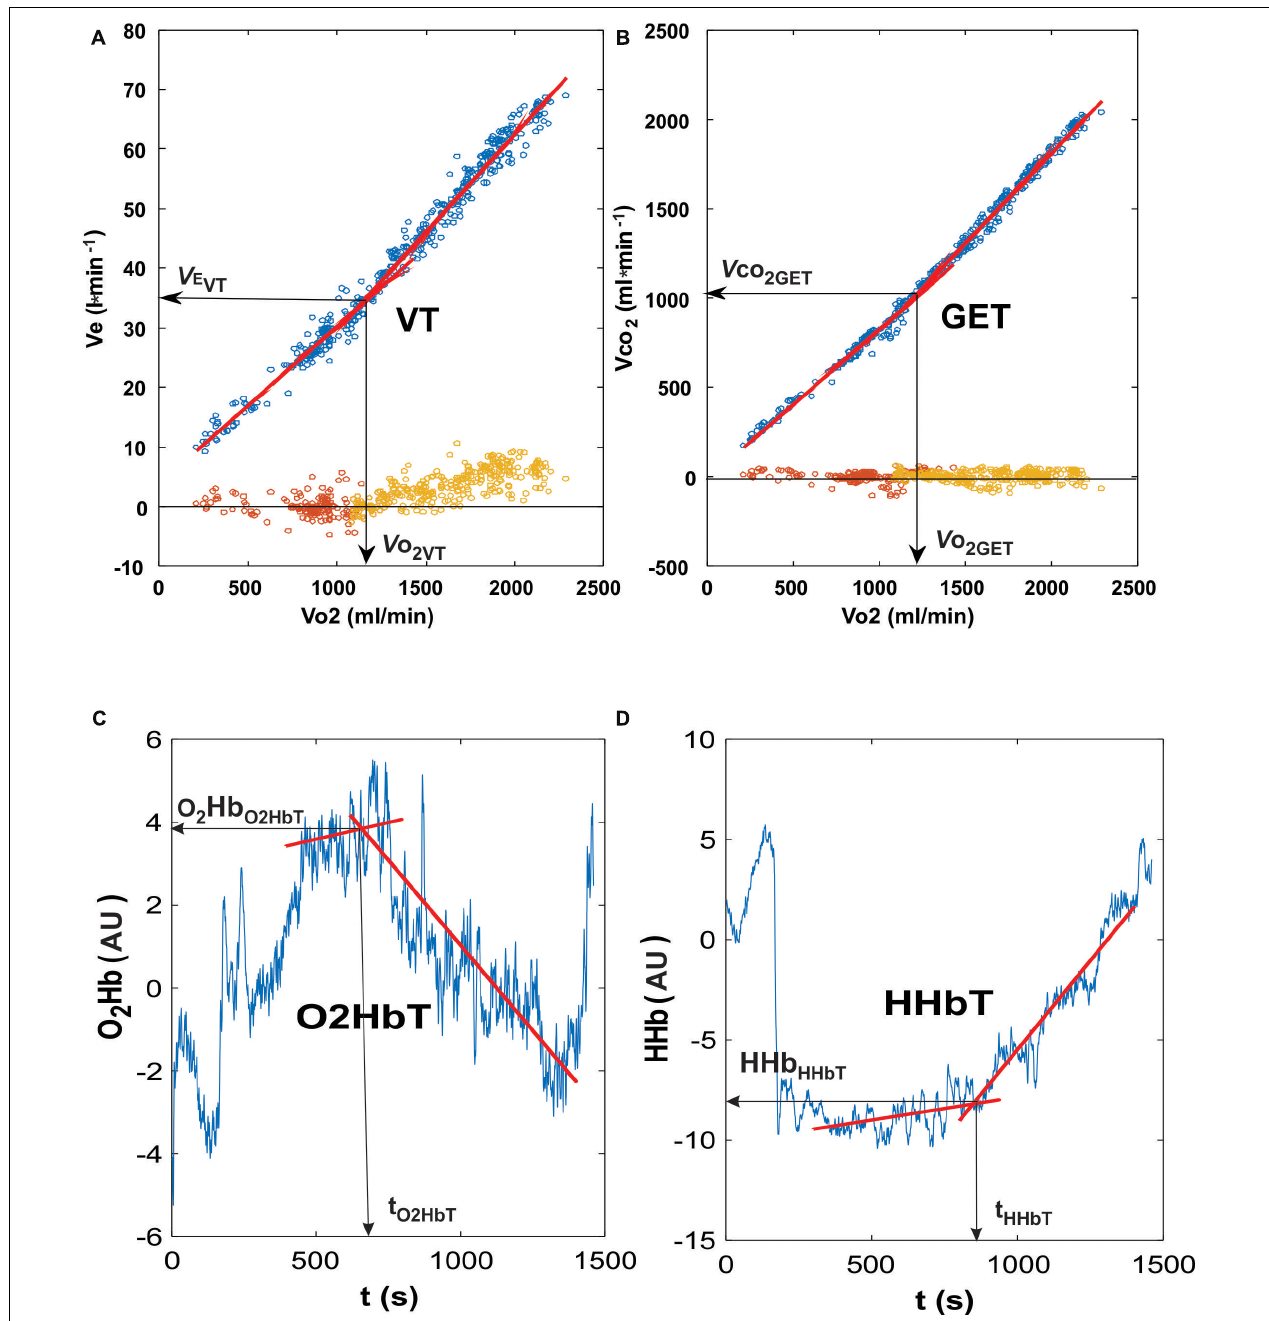
FIGURE 1 | Representative curves for the ventilatory and oxygenation thresholds used in the present analysis. The determination of Ventilatory Threshold (VT; A) was performed using the intersection point of the two best fitting lines (the lowest residuals at the bottom of the diagram, around zero line) when plotting minute ventilation and oxygen consumption. The gas exchange threshold (GET; B) was determined by using the intersection point of the two best fitting lines when plotting carbon dioxide and oxygen consumption. Residuals were plotted at the bottom of the graph (around zero axis value). Both the oxygenated hemoglobin (O 2 Hb) and deoxygenated hemoglobin (HHb) thresholds (C,D , respectively) represent the intersection points of the two best fitted lines of measured